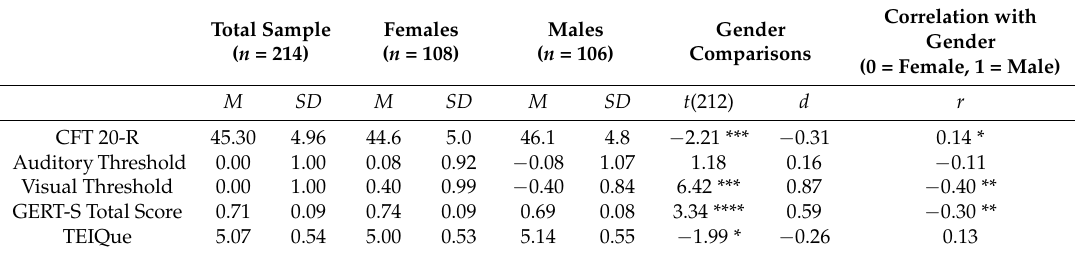
Table 1. Descriptive statistics of cognitive abilities, emotion recognition, and trait emotional intelligence measures, and t -tests with effect size estimates comparing male and female participants.